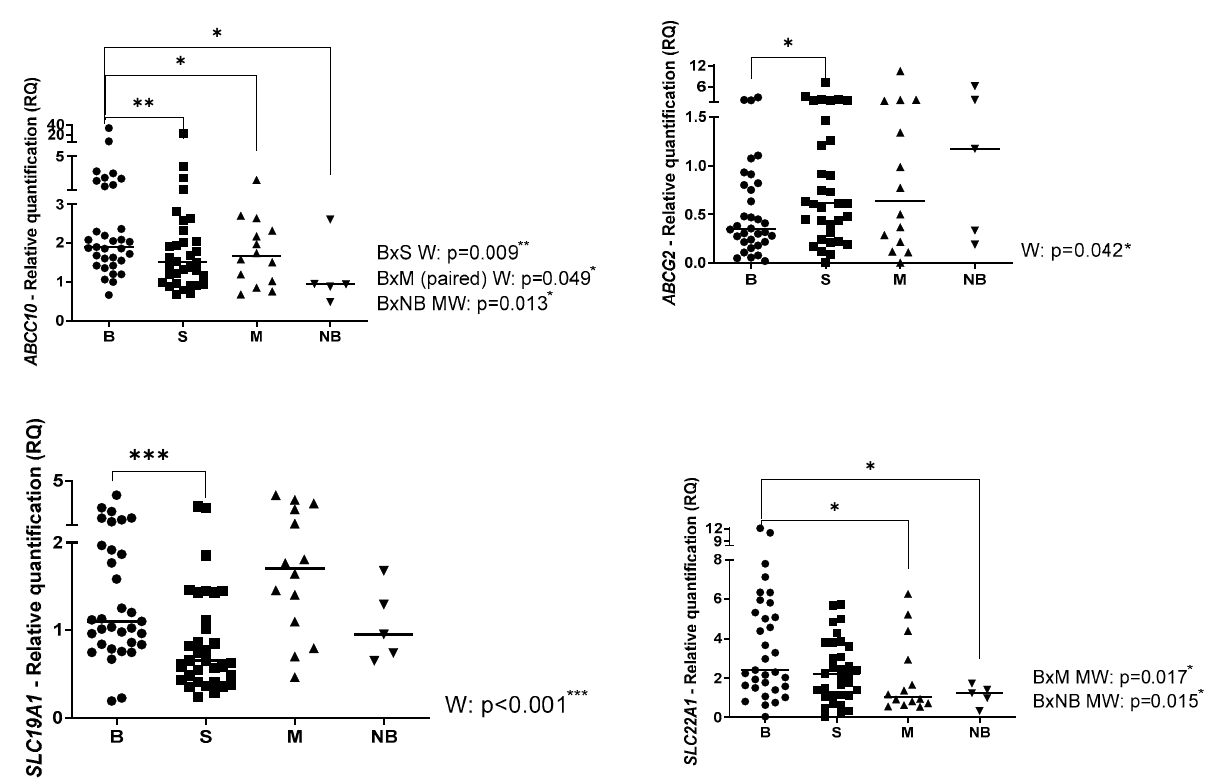
Figure 1. The relative quantification (RQ) in the pre-chemotherapy (B), post-chemotherapy (S), metastasis (M) and normal bone (NB) specimens. W: Wilcoxon Test; MW: Mann-Whitney Test. * p < 0.05; ** p < 0.01; *** p < 0.001; **** p < 0.0001.